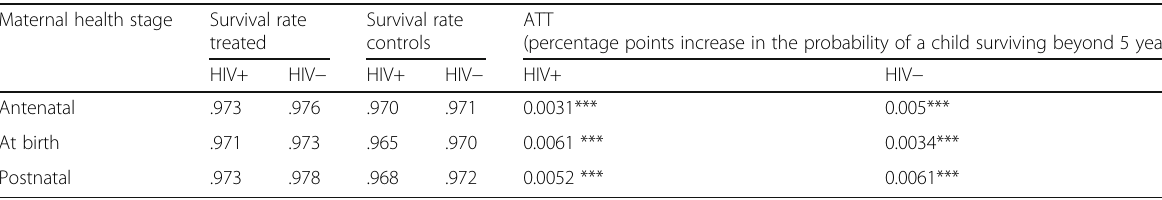
Table 4 Matching using Kernel method